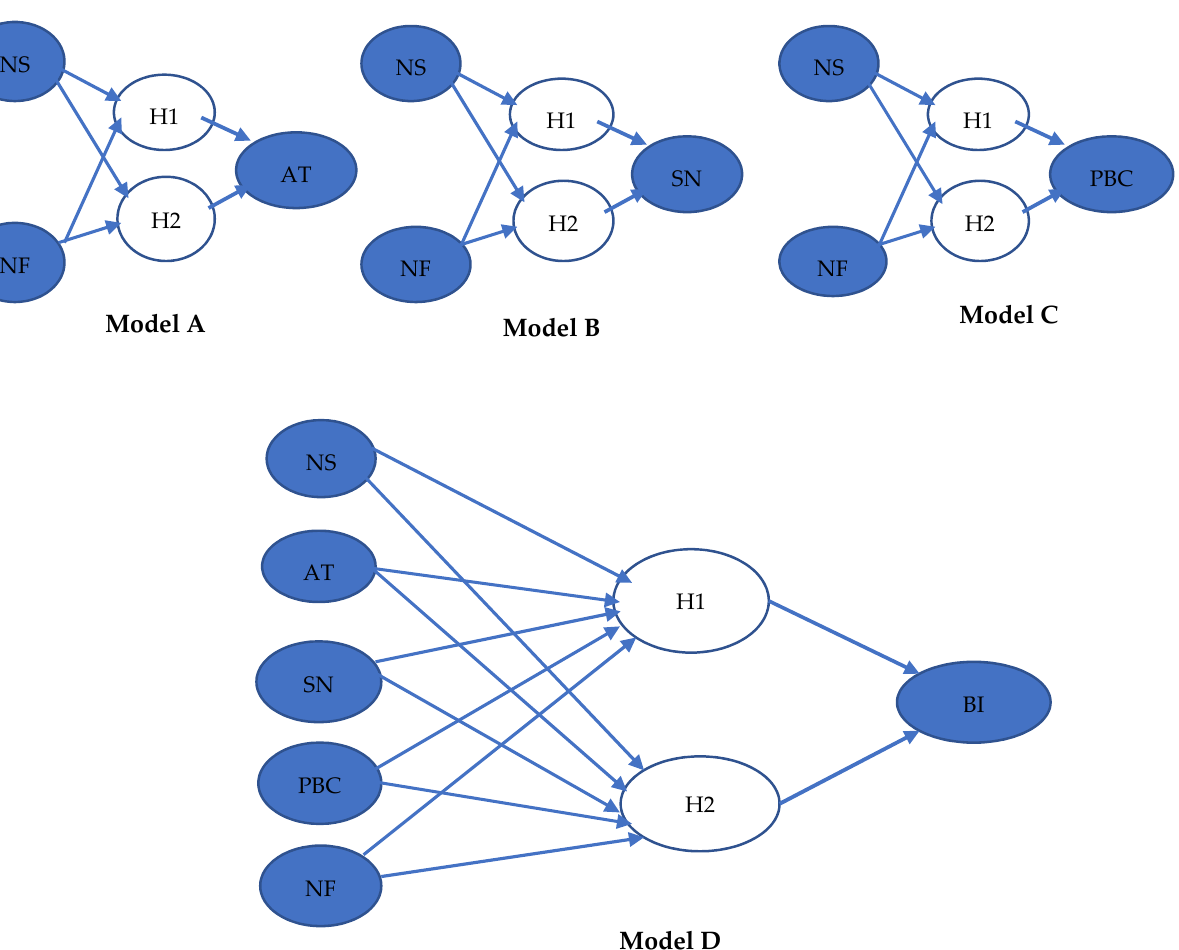
Figure 3. Neural network models.